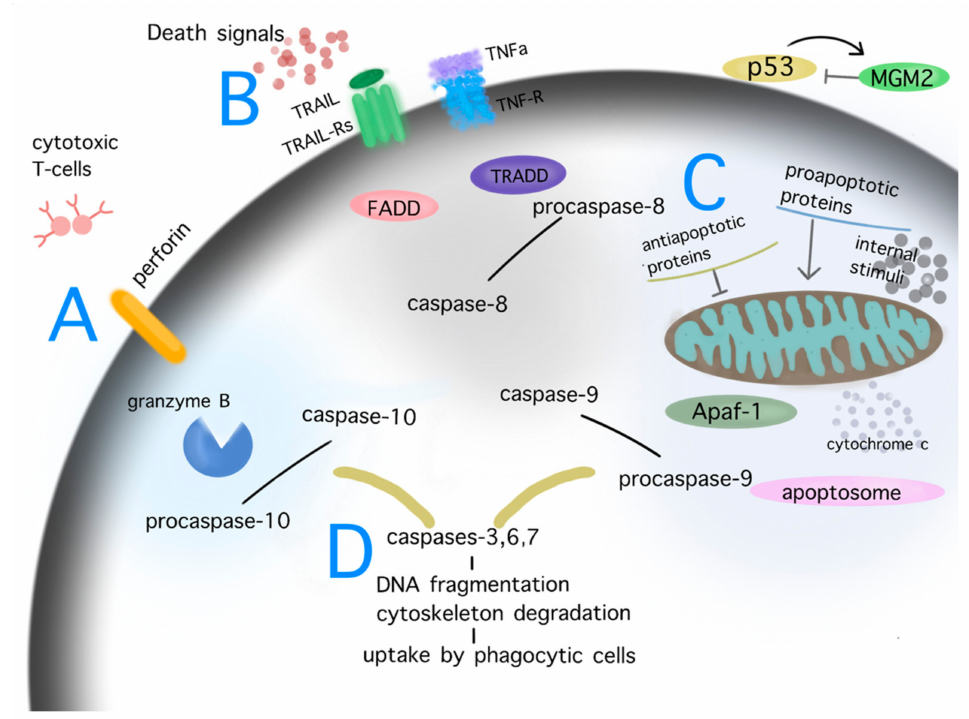
Figure 2. Pathways of apoptosis. Depiction of the cascades of apoptosis. Diverse internal and external stimuli causing persistent damage signaling, such as DNA damage, cellular stress, telomere shortening, ionizing radiation, mitochondrial dysfunction, heat, hypoxia, may trigger the process of apoptosis via the perforin/granzyme ( A ), extrinsic ( B ) or intrinsic/mitochondrial ( C ) pathway. The aforementioned processes activate the final step of apoptosis, named the executive pathway of apoptosis ( D ). During these procedures, initiators (caspases 8, 9, 10) and effectors caspases (caspases 3, 6, 7) are key players in the degradation of critical cell structures until the phagocytosis of the apoptotic cell. Under physiological conditions, p53 activity is controlled by MGM2; in the case of severe permanent damage, signaling p53 is upregulated and triggers the extrinsic and intrinsic pathway of apoptosis. Abbreviations: FADD: Fas-associated protein with death domain; TRADD: tumor necrosis factor receptor type1-associated death domain protein; MGM2: mouse double